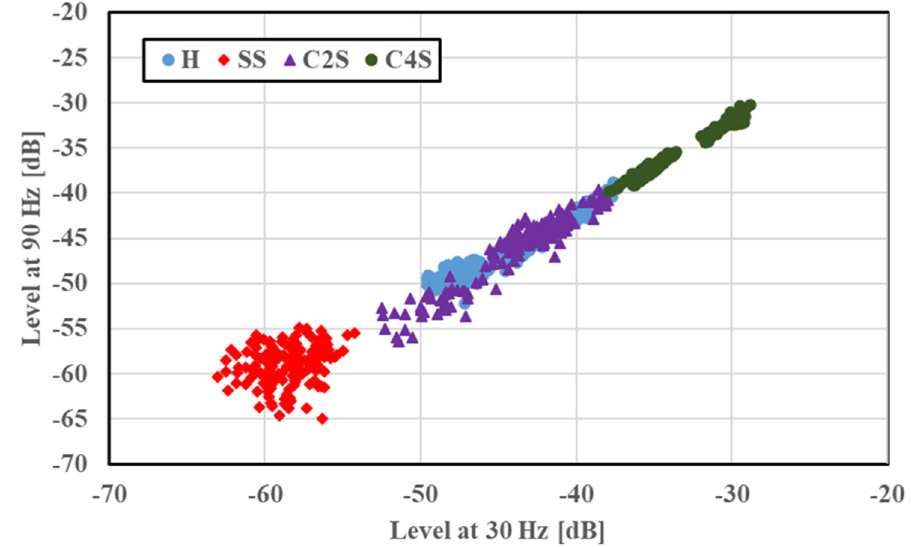
Figure 8. Feature distribution without considering the rotation speed (concentrated scratch).